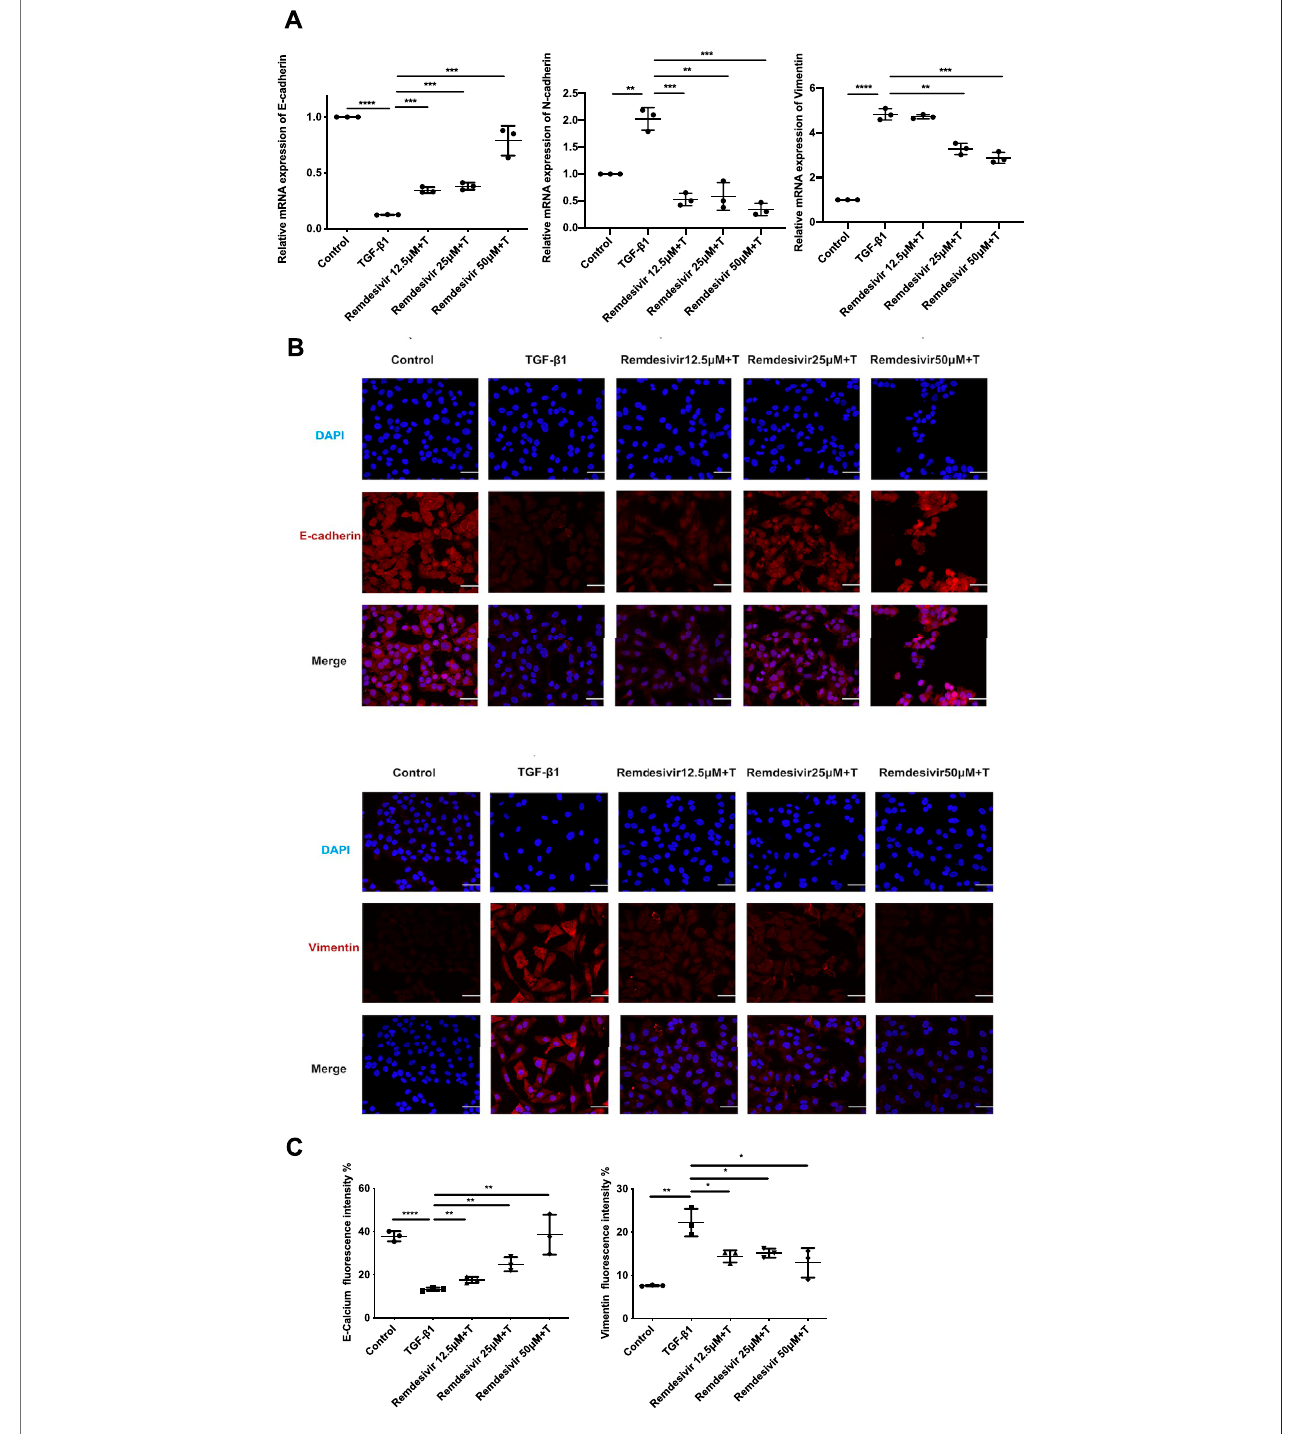
FIGURE 8 | Remdesivir inhibits TGF- β 1-induced epithelial to mesenchymal transition in alveolar epithelial cells. A549 cells were co-treated with Remdesivir (12.5, 25, 50 μ M) and TGF- β 1 (5 ng ml − 1 ) for 24 h (A) mRNA levels of E-cadherin, N-cadherin and Vimentin were tested by RT-PCR in A549 cells. (B – C) Immuno fl uorescence analysis of E-cadherin and Vimentin in A549 cells. Scale bar (cid:1) 50 μ m. Data was presented as the means ± SD, n (cid:1) 3. * p < 0.05, ** p < 0.01, *** p < 0.001.